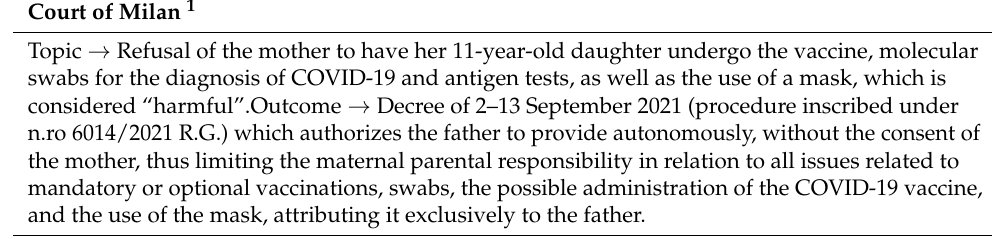
Table 3. Rulings of the Italian Court on the matter in question. Court of Milan